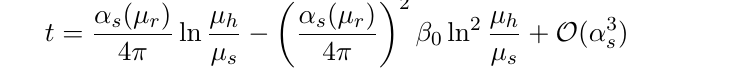
Figure 7 . Results of the resummation of the non-global logarithms in t (cid:22) t production at with a veto on additional jets in the two regions with j y j < 0 : 8 (left) and j y j < 2 : 1 (right). The full leading logarithmic resummed result is shown in blue, its expansions to NLO in brown and to NNLO in pink. The blue dashed line is the resummed result when the radiation from the decay is omitted. The (cid:12)xed-order calculation to NLO is shown in green. The uncertainty bands are from scale variation, see